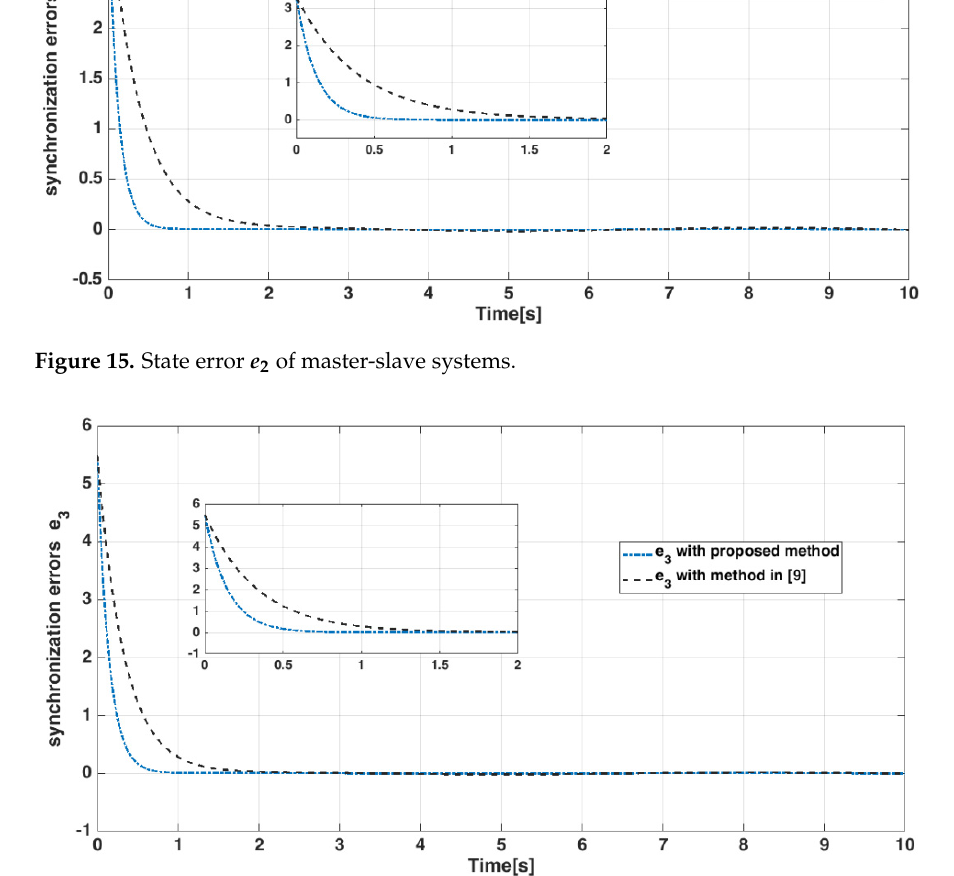
Figure 17. State error 𝒆 𝟒 of master-slave systems